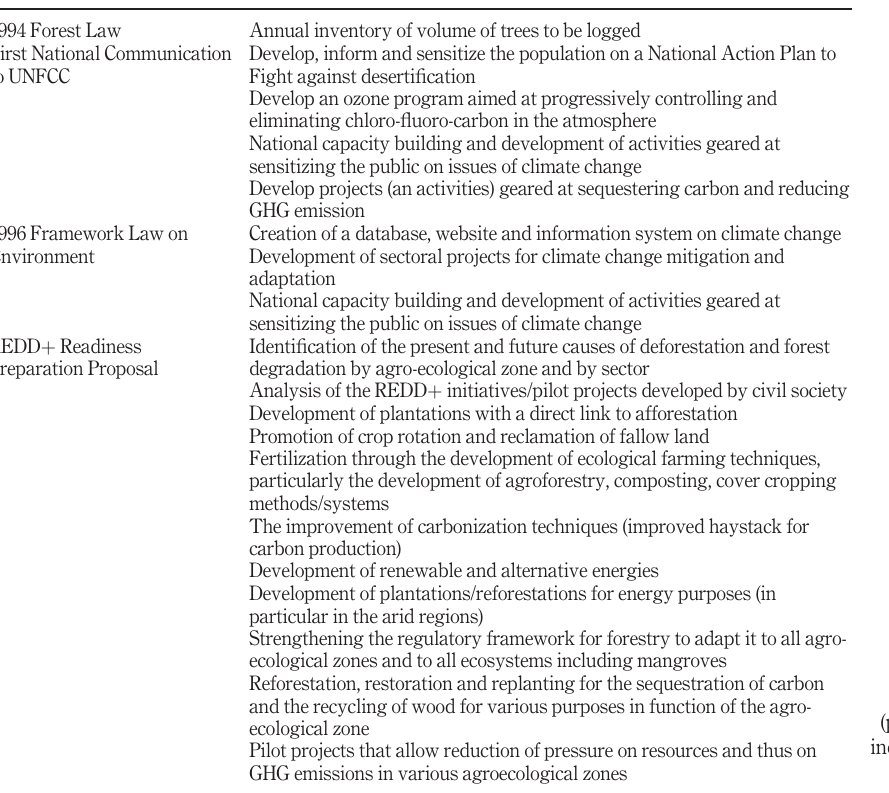
Table II. Proposed